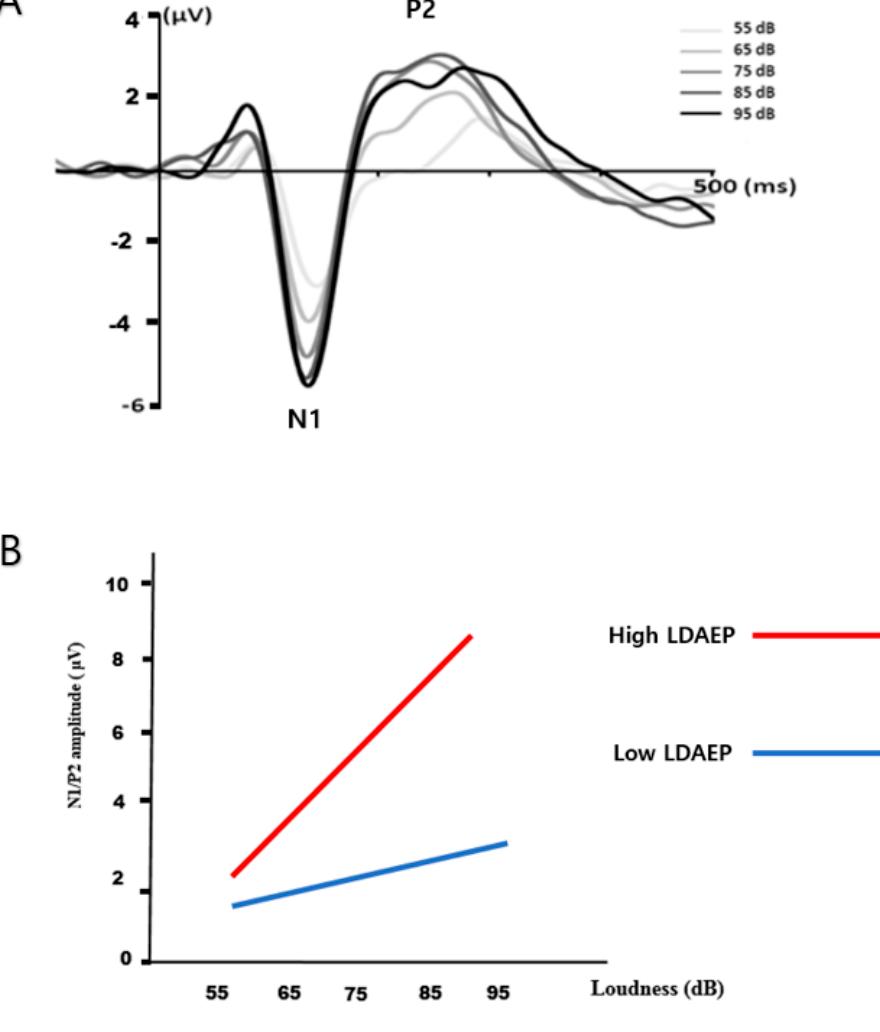
Figure 1. ( A ) Illustration of the loudness dependence of auditory evoked potential (LDAEP). The peak-to-peak N1/P2 amplitudes were measured for the five stimulus intensities, and the LDAEP was calculated as the slope of the linear-regression curve. ( B ) Illustration of a high and steep LDAEP (a large increase in N1/P2 amplitude with increasing loudness: a red line) and a low and shallow LDAEP (a small increase in N1/P2 amplitude with increasing loudness: a blue line).